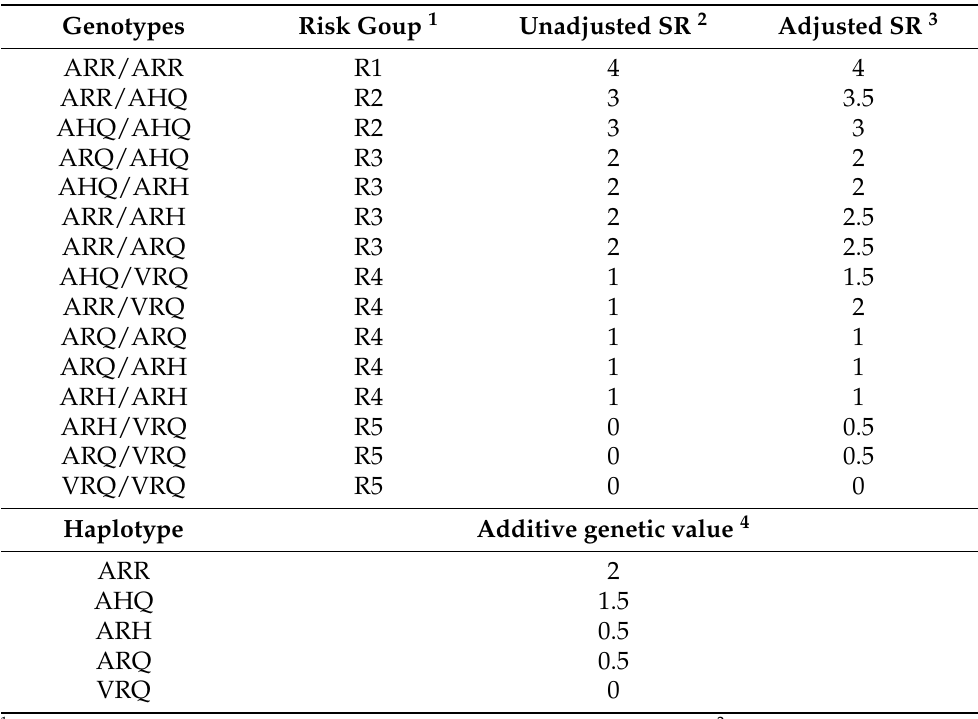
Table 1. Risk groups, unadjusted and adjusted scrapie resistance genotypes, and additive genetic values for scrapie resistance for each haplotype.